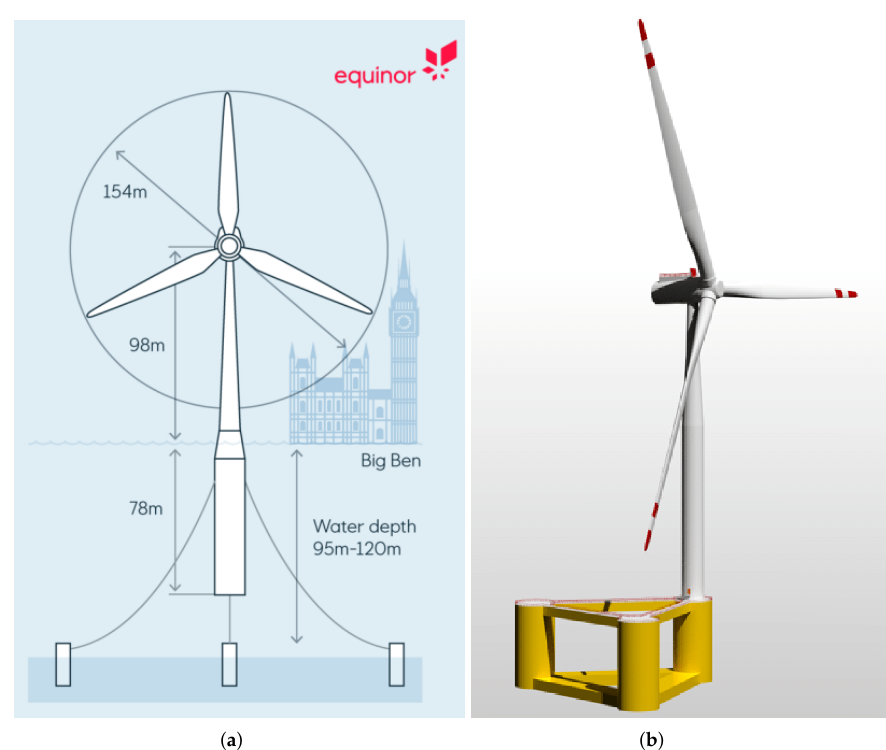
Figure 8. Spar and semi-submersible type FOWTs. ( a ) The Hywind Scotland wind park is located 25 km east of Peterhead in Scotland. Courtesy of Equinor. ( b ) The 12 MW INO WINDMOOR FOWT [57]. There is no well-established, concrete analytical method for VIM responses of